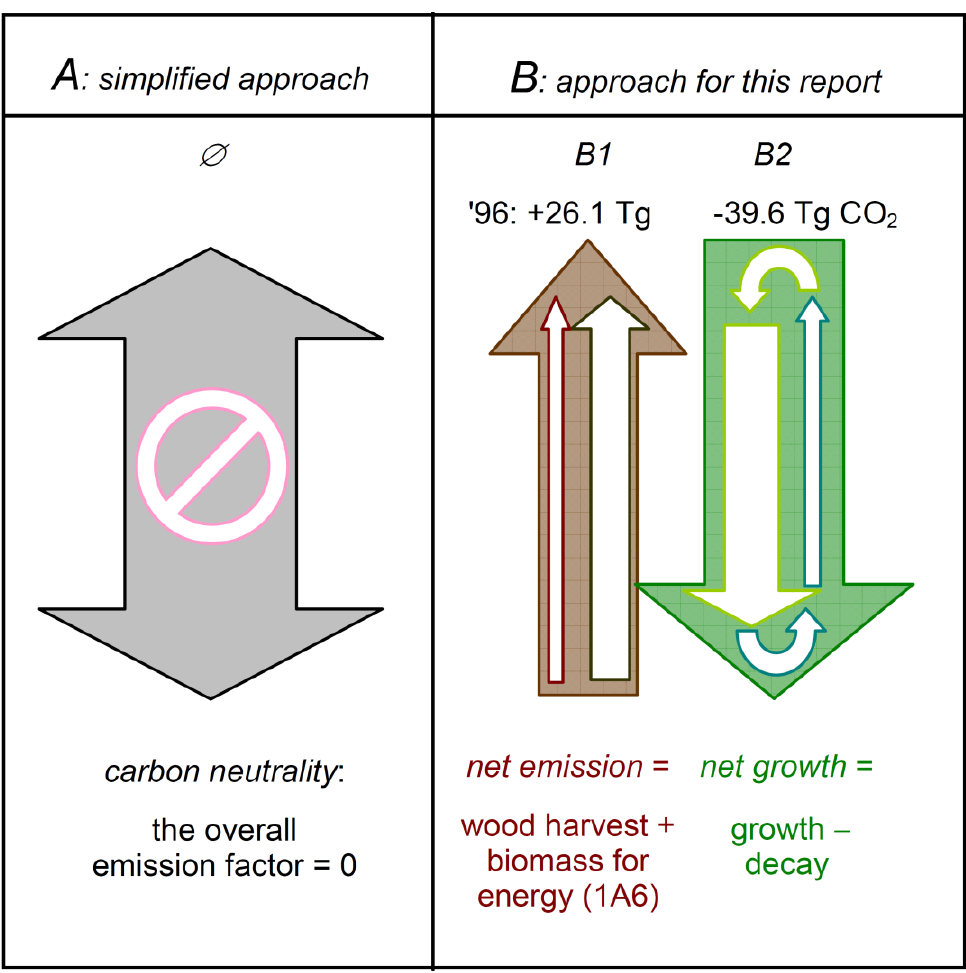
Figure 12. Two different approaches when accounting of carbon flows for Austria’s biomass energy for the year 1996: ( A ): simplified approach assuming carbon neutrality; ( B ): suggested approach for the year 1996: ( A ) simplified approach assuming carbon neutrality; ( B ) suggested approach based based on the CEBM, differentiating into the single flows correctly. Image source: [85]. on the CEBM, differentiating into the single flows correctly. Image source: